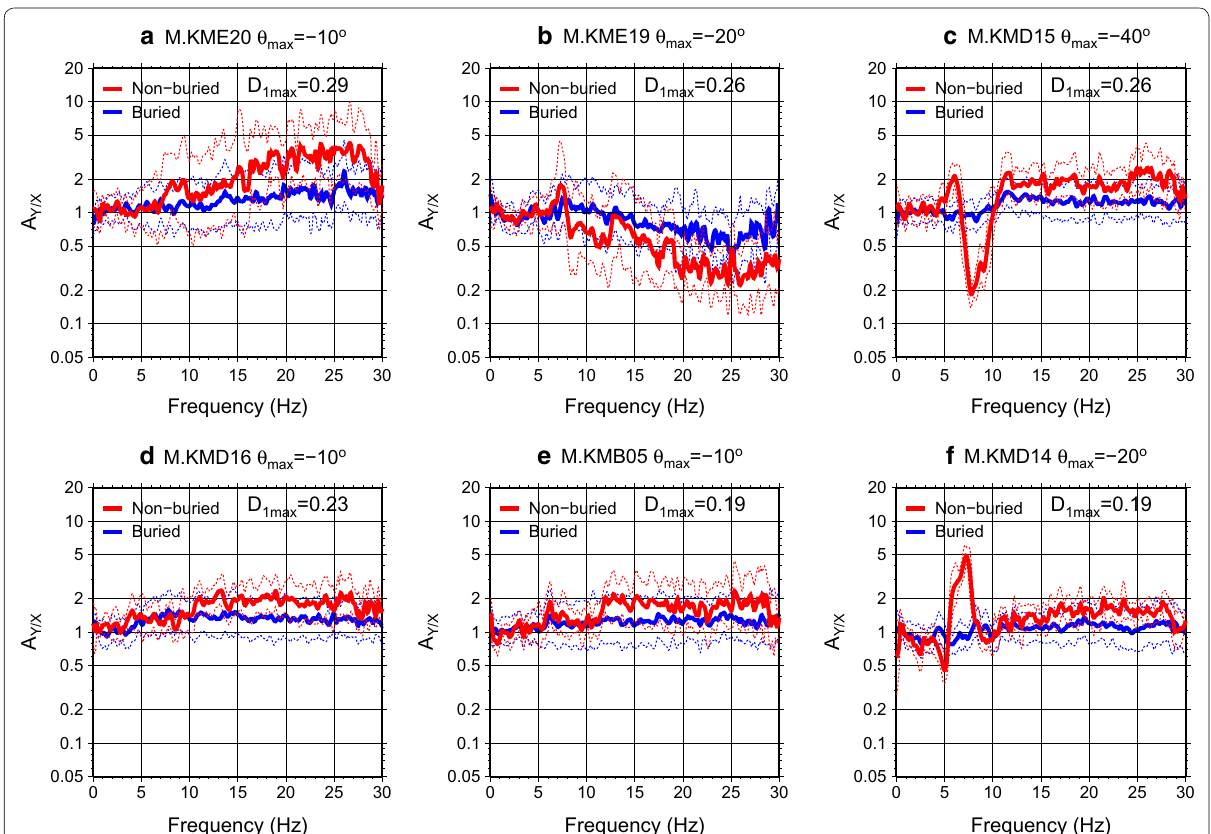
Fig. 10 Average Y/X amplitude spectral ratio (solid red curves) and logarithmic standard deviation (dotted red curves) at θ non-buried DONET1 stations with the largest D 1max . The θ max and D 1max values for each station are written at the top and inside of each subfigure, respectively. Solid and dotted blue curves represent the average Y/X amplitude spectral ratio and logarithmic standard deviation, respectively, obtained in the buried time period for each station, where the rotation angle θ is equal to θ max ° estimated in the non-buried time